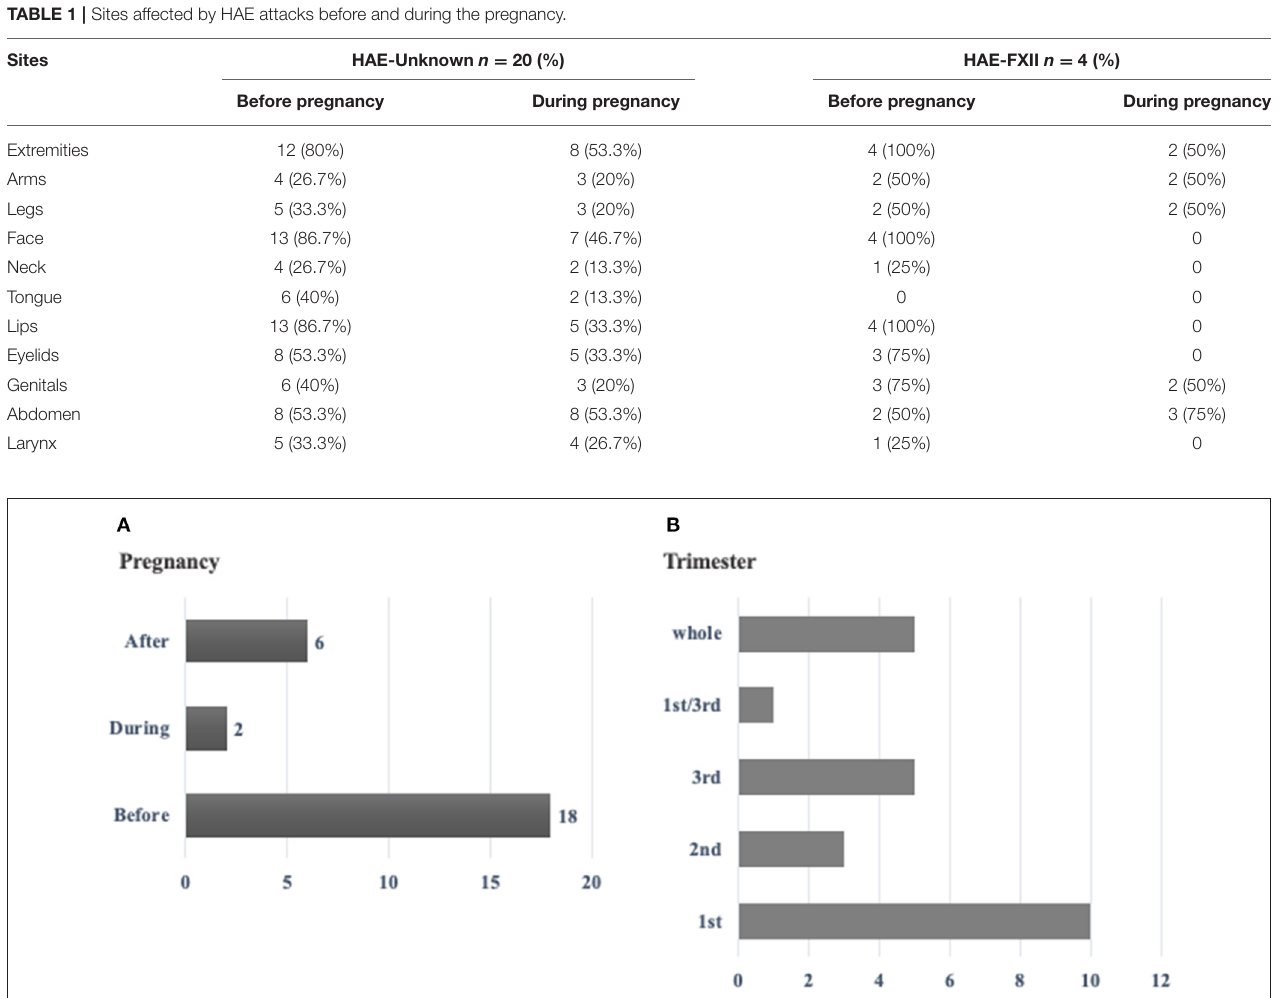
FIGURE 1 | (A) Development of HAE symptoms in 26 pregnant women before, during or after the pregnancy*. (B) Occurrence of HAE attacks in 24 pregnant women with HAE-nC1-INH according to the period of the pregnancy**. *Before pregnancy corresponds to the year before getting pregnant. During the pregnancy corresponds to the total period of pregnancy. After the pregnancy corresponds to the period of 6 months after delivery. **Whole period means that the women presented attacks during the whole